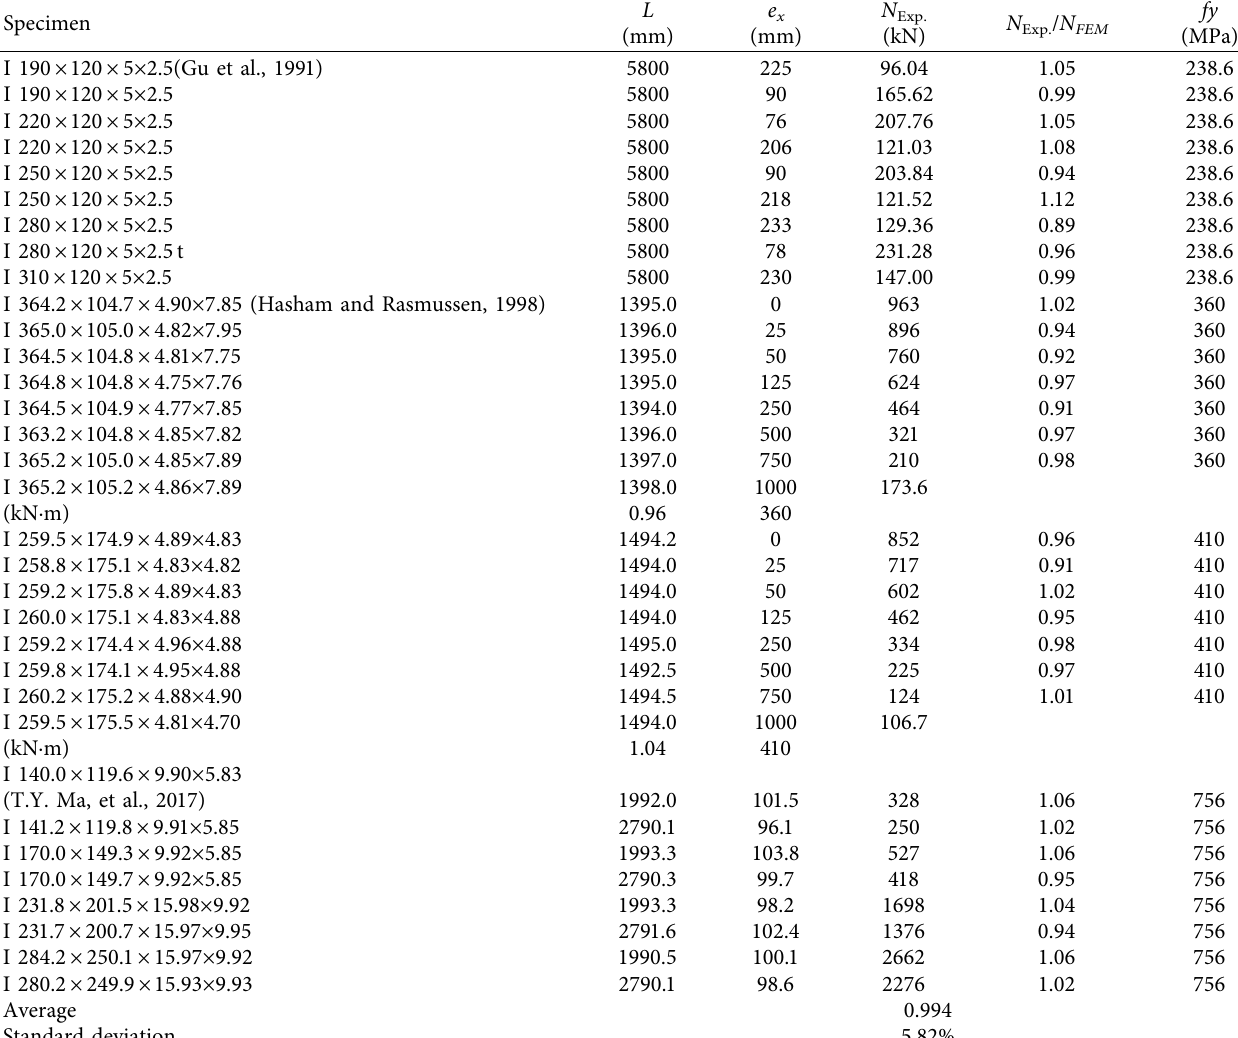
Table 2: Compared of FEM and experiment